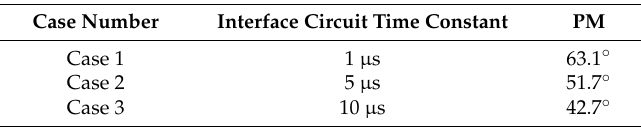
Table 3. Time constant and PM of considered cases.